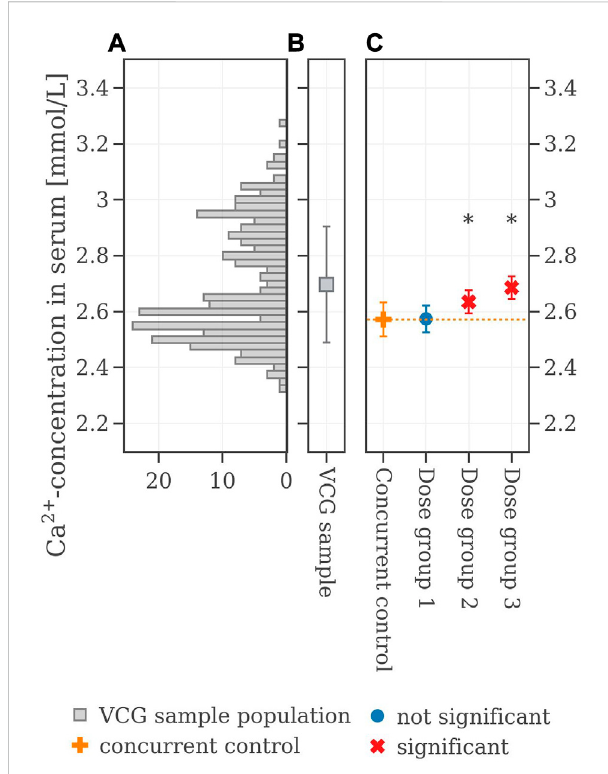
FIGURE 3 (A) Histogram of the calcium values of the VCG sample population. (B) Boxplot of the VCG sample population. (C) Extracted originalresults ofserum calciumconcentration fromthelegacy